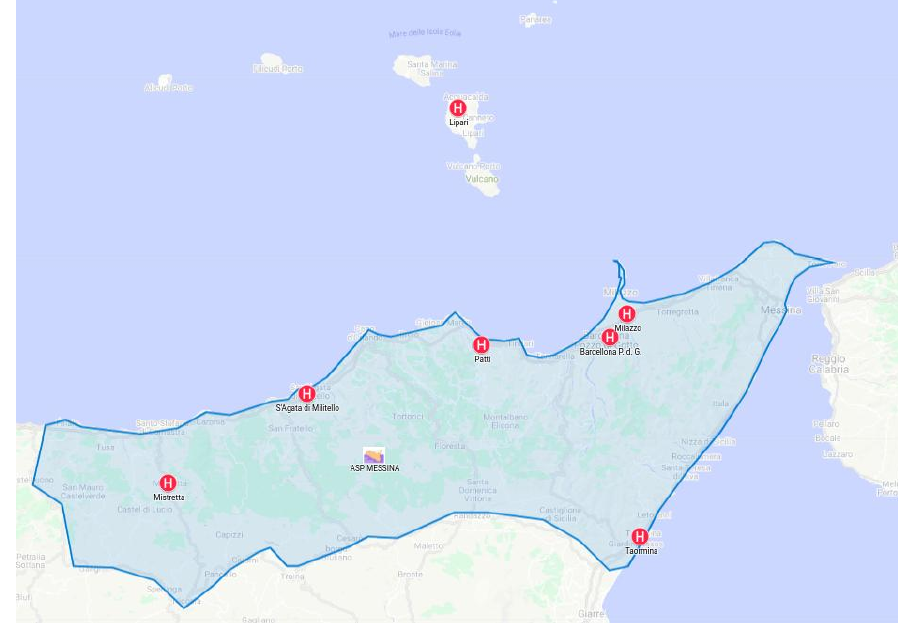
Figure 1. Federation of hospitals: clinical data is shared across participants for